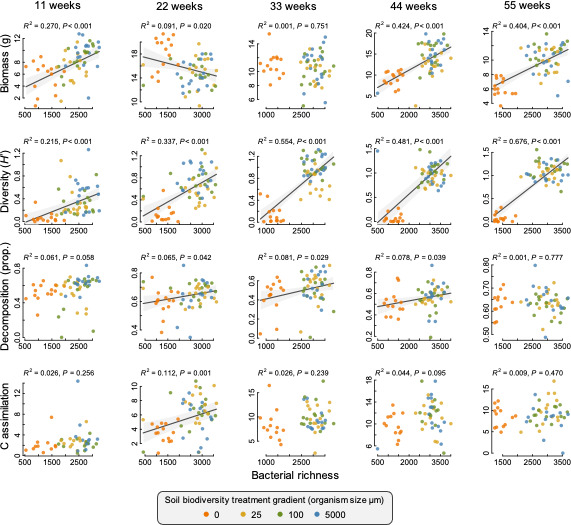
Bacterial richness-ecosystem function relationships for each time point.Solid lines indicate a significant relationship (p<0.05), and the grey shaded region is the 95% confidence band for the relationship. Fit statistics (R2 and p-value) for each are also provided above each plot. Points are individual mesocosms coloured by their soil biodiversity treatment.